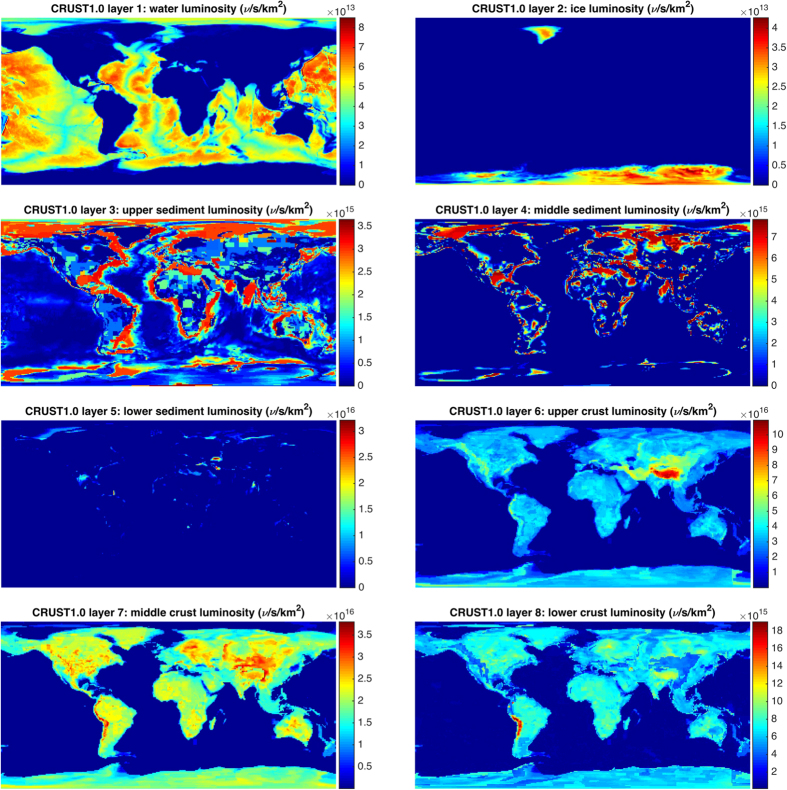
AGM2015  luminosity per km2 per CRUST1.0 layer.Each CRUST1.0 layer is composed of 180 × 360 1° tiles, each with a defined thickness (ranging from 0–78 km) and density (ranging from 0.9–3.4 g/cm3). Note the layers have different colorbar scales. Figure created with MATLAB45.